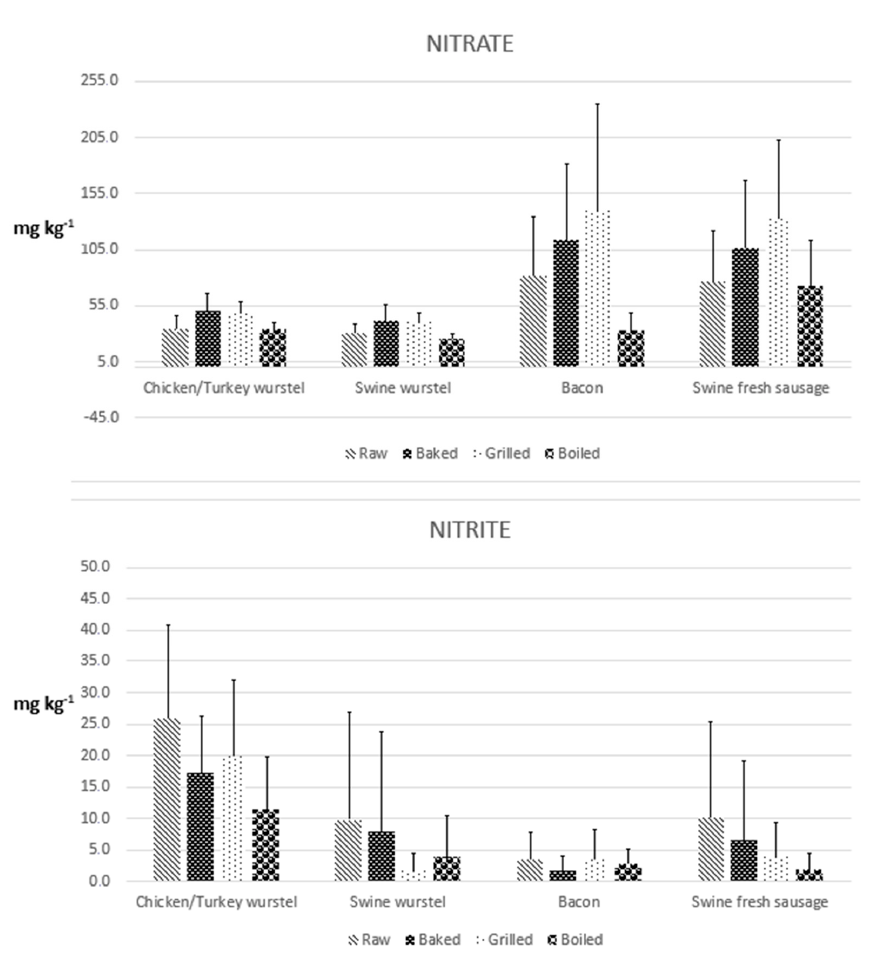
Figure 1. Mean concentrations of nitrite and nitrate quantified analyzing 60 samples of meat products both before and after